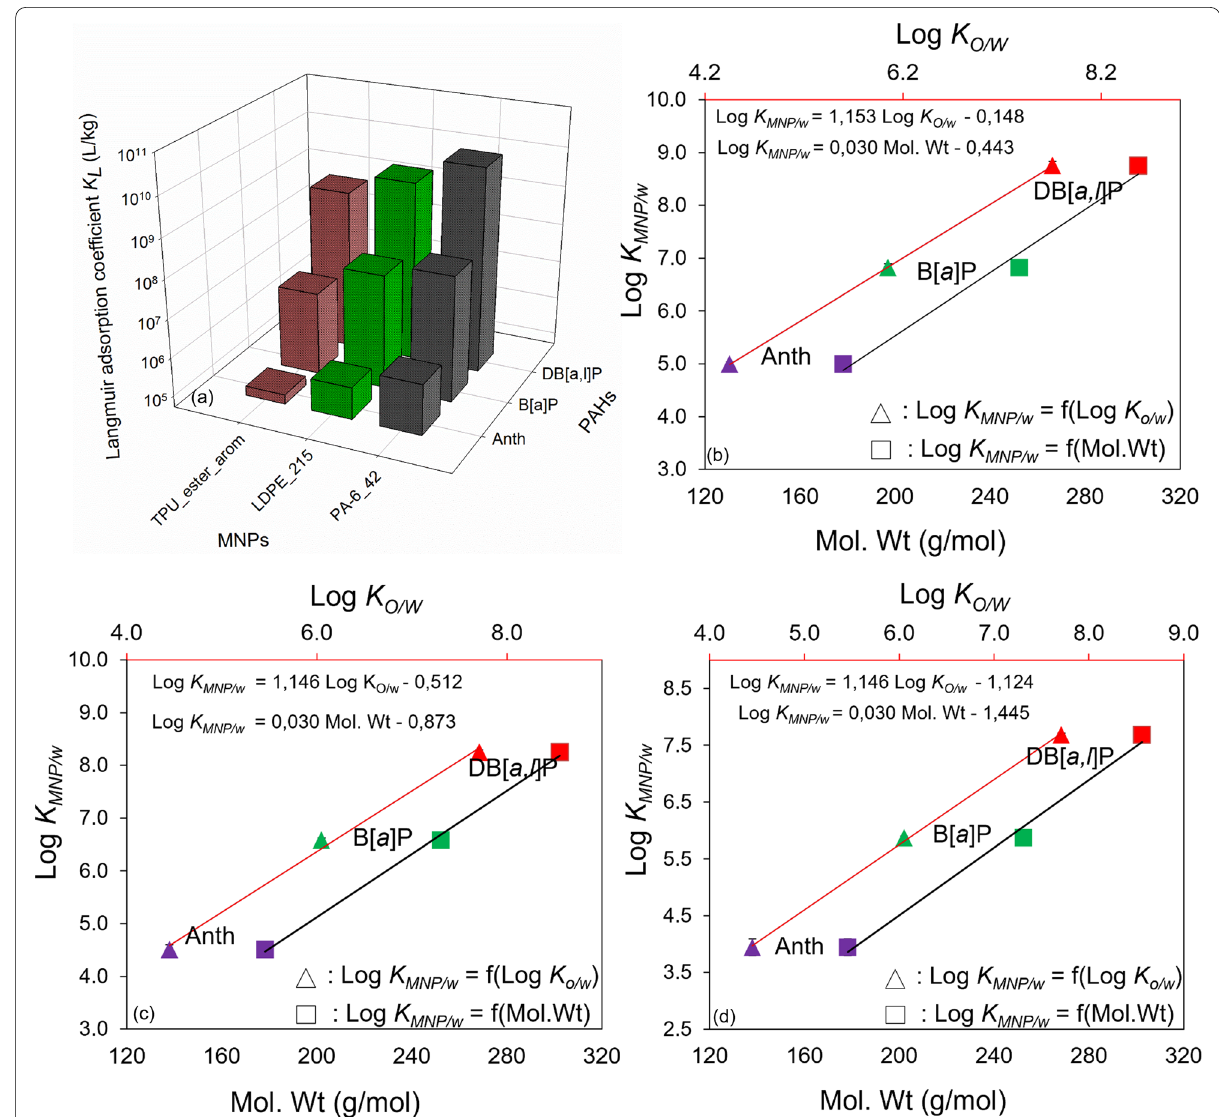
Fig. 6 a Comparison of the Langmuir adsorption coefficients K L for selected MNPs and different PAHs (z-axis is expressed in logarithmic scale). Plots of log K MNP/w as functions of log K o/w and molecular weight (Mol. Wt) for ( b ) PA-6_42, ( c ) LDPE_215 and ( d ) TPU_ester_arom, illustrating the correlation of sorption coefficients and hydrophobicity of the studied PAHs (log K o / w : 4.45 (Anth), 6.05 (B[ a ]P), 7.71 (DB[ a,l